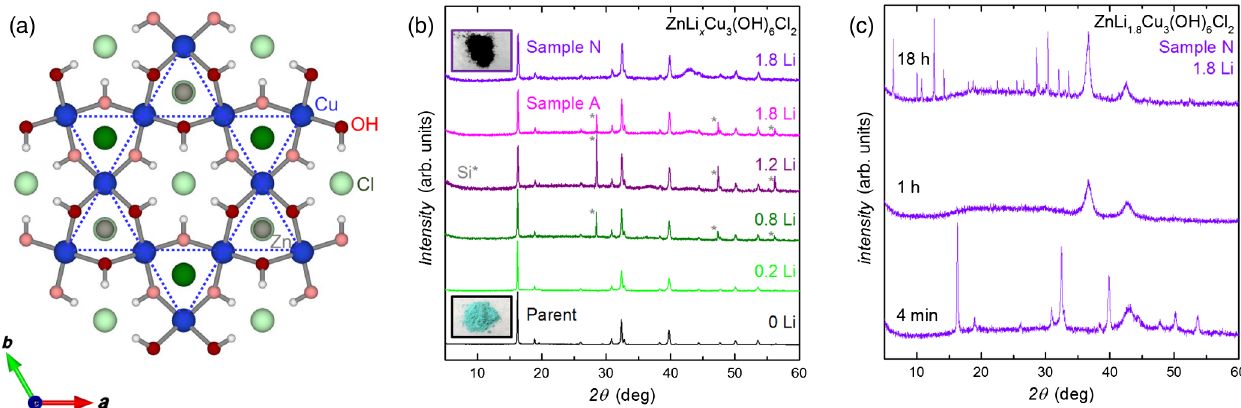
FIG. 1. Doped herbertsmithite structure. (a) A top-down (along c axis) representation of the parent herbertsmithite copper kagome layer (blue dotted line) with Cu (blue) and O (red), H (white), Zn (gray), and Cl (green) between the kagome layers. The dark and light atoms are located above and below the kagome plane, respectively. (b) Thex-ray powder diffraction (XRPD) patterns of the complete series. Thegray asterisks represent the presence of Si (internal standard). An image of the blue-green parent material is shown in the lower left-hand corner while a picture of the black doped sample N is shown in the upper left. All doped samples are also black. (c) XRPD data demonstrate the instability of one of the maximally doped samples, sample N, in air ( x ¼ 1 . 8 ) as it decomposes in hours into several other